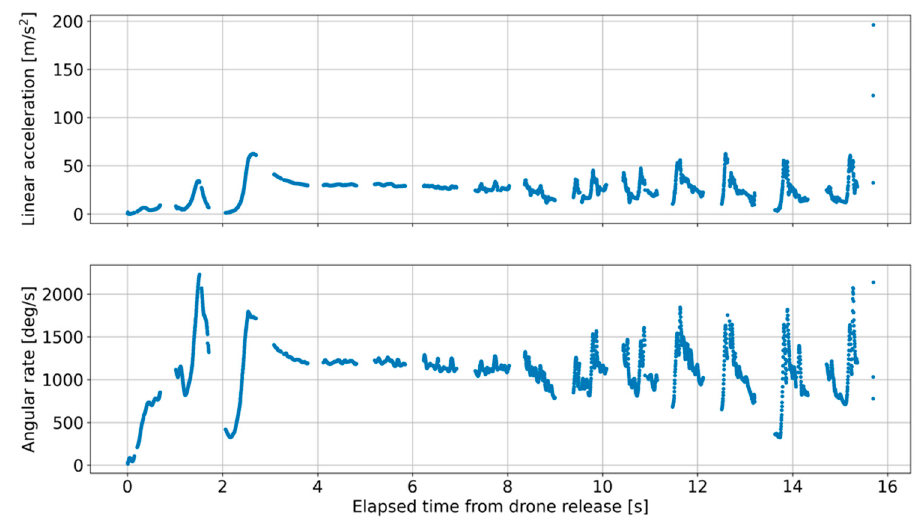
Figure 21. TA2 linear acceleration and rotation rate for complete flight, 0 < t < 15.7 s.